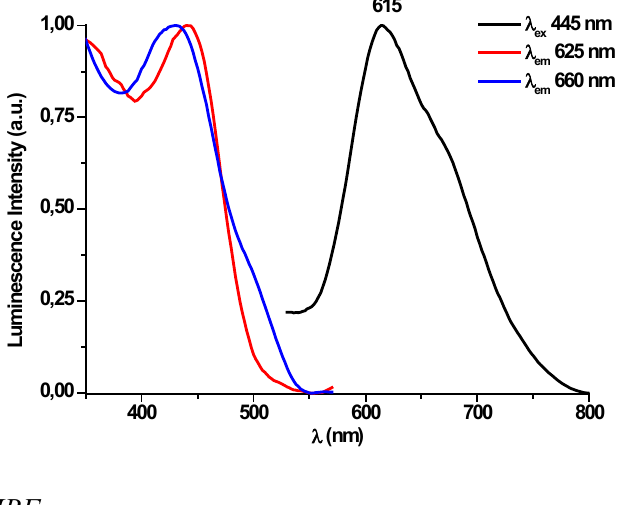
Figure 5. Excitation and emission spectra of 2 in solid state at 77 K. (first